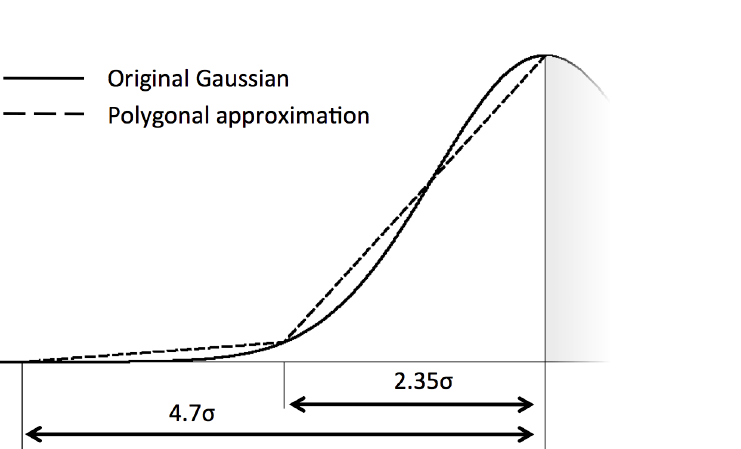
Figure 5. Linear approximation of gaussian MFs in the range [ − 4 . 7 σ , 0], compared to a gaussian